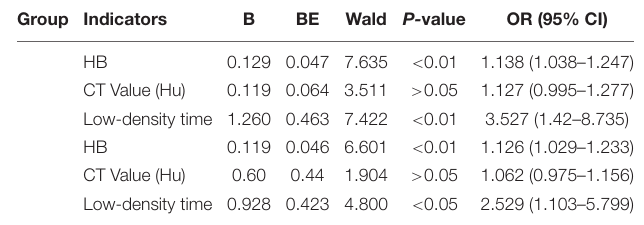
TABLE 3 | Results of logistic regression analysis indicating predictors of risk factors.